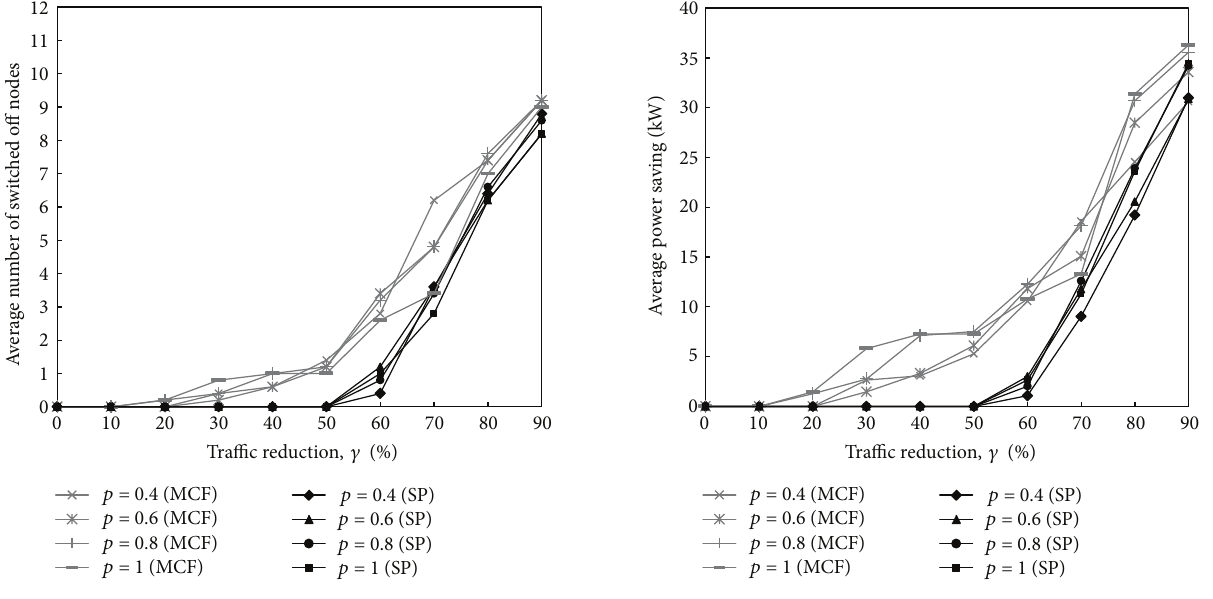
Figure 4: Average number of switched off nodes obtained using MEE Heuristic with MCF and Dijkstra rerouting approach and in the case of the Network 6-3-4.